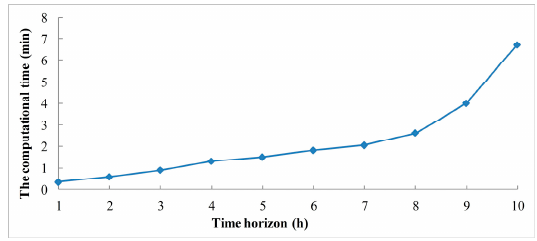
Figure 14. The time performance of the continuous-time dynamic network flow algorithm in solving the EMVDR problem.